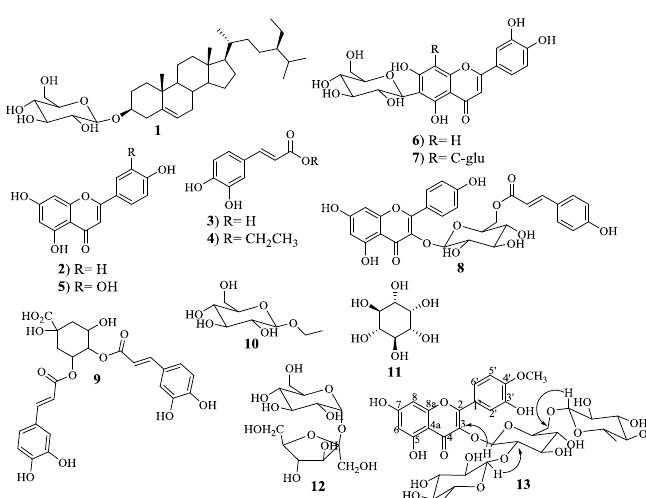
Figure 1. Structures of isolated compounds: β-sitosterol-β- D -glucoside 1 , apiginin 2 , caffeic acid 3 , ethyl caffeate 4 , luteolin 5 , isoorientin 6 , lucenin 2 7 , tiliroside 8 , 4,5- O -dicaffeoylquinic acid 9 , 1- O -ethyl-β- D -glucoside 10 , myo-inositol 11 , β- D -fructofuranosyl-(2 → 1)-α- D -glucoside 12 and tamarixetin 3-β- L -rhamnosyl-(1 → 2)[β- L -rhamnosyl-(1 → 6)]β- D -glucoside] 13 .